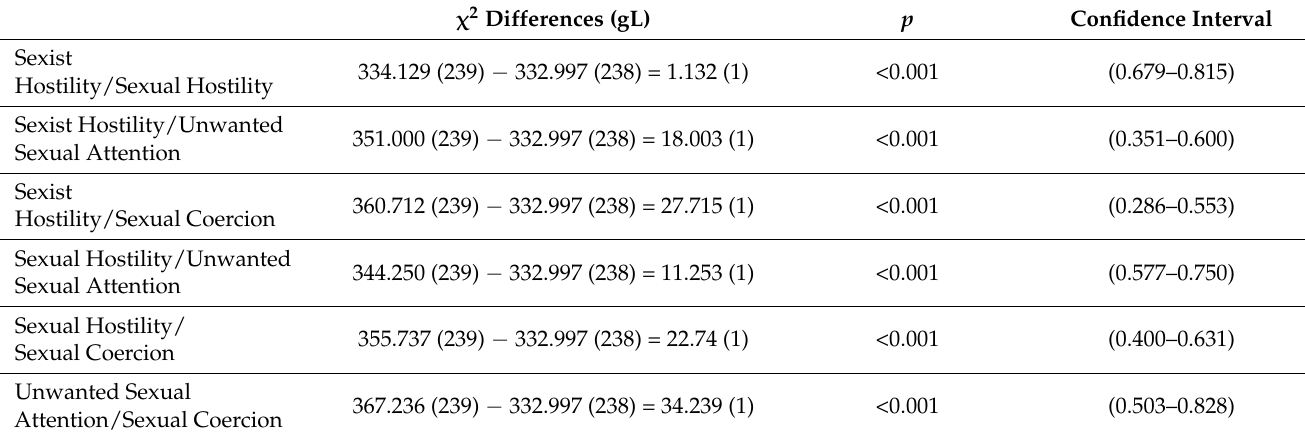
Table 3. Test of χ 2 differences; confidence intervals of correlations between dimensions. χ 2 Differences